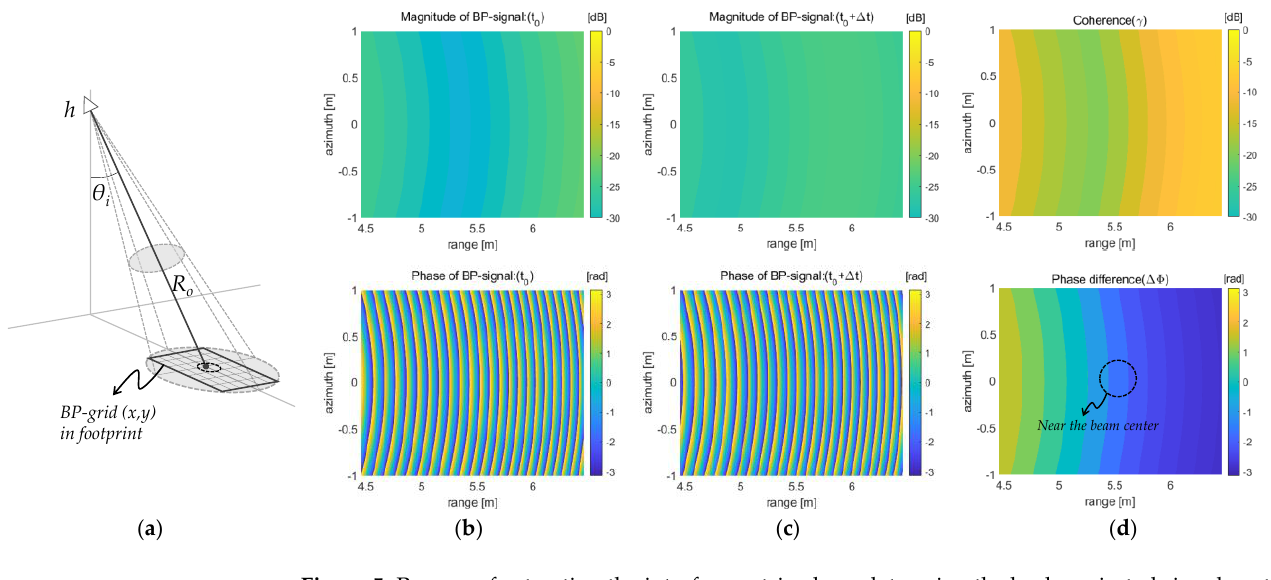
Figure 5. Process of extracting the interferometric phase data using the back-projected signals onto the reference grid: ( a ) the radar geometry for the back-projection; ( b , c ) the back-projected signals’ magnitude and phase terms at the initial time step ( t 0 ) and the next time step ( t 0 + ∆ t ); ( d ) the Pearson’s product–moment correlation coefficients (or coherence map) and the self-interferometric phase.